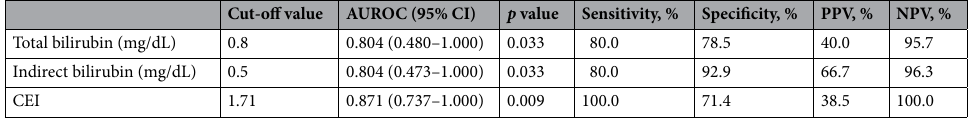
Table 4. ROC curve analysis of each baseline parameter and prediction of grade ≥ 2 hyperbilirubinemia. AUROC area under the receiver operating characteristic curve, CEI contrast enhancement index, CI confidence interval, NPV negative predictive value, PPV positive predictive